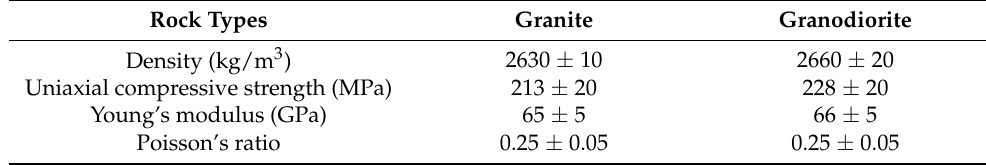
Figure 1. The final shape of the brittle failure of the test tunnel: ( a ) photograph [26,27]; ( b ) outline. Table 2. Rock mechanics parameters provided by CANMET.